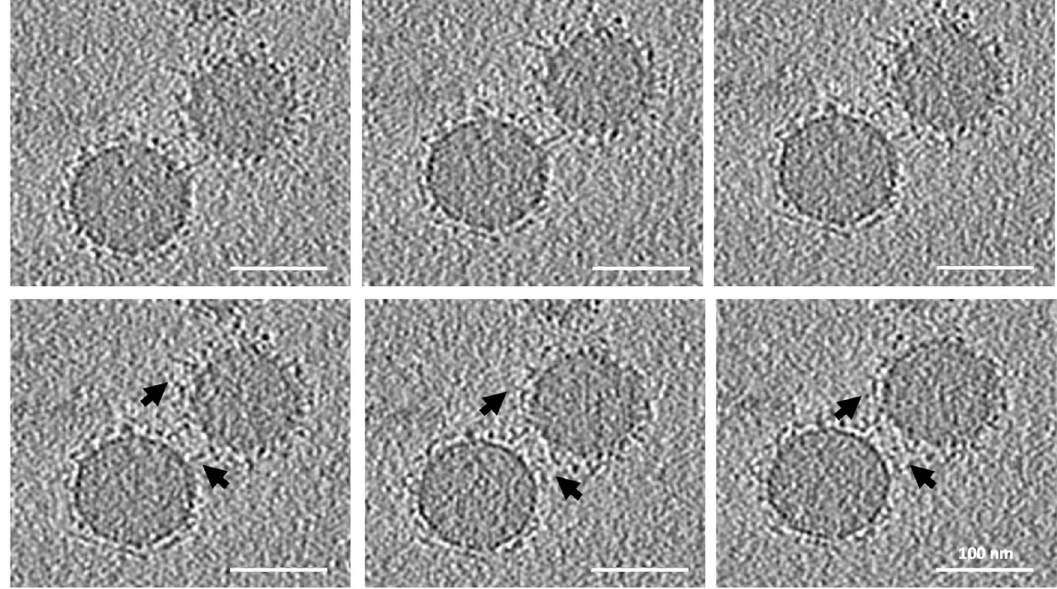
Fig. 4 Selected slices from the reconstructed tomographic 3D volume (see Supplementary Figs. 3, 4, and Supplementary Movies 5 – 23 of the Supplementary Information; see the image analysis section for details of the generation of the 3D corona decoration). The 2D images represent virtual slices through the reconstructed 3D volume of the NPs and corona, from top to bottom. Local distribution and association of the biomolecules within the corona on the surface of the NPs are visible. The biomolecules appear as a dark dense structure bound to the surface of the NPs and at distances from the surface. Changes in the appearance of the individual dots from one image to the next image (see arrows) indicate that the size of these dots, representing biomolecules, is ~1 nm. The scale bar for all images in the panel are the same (100